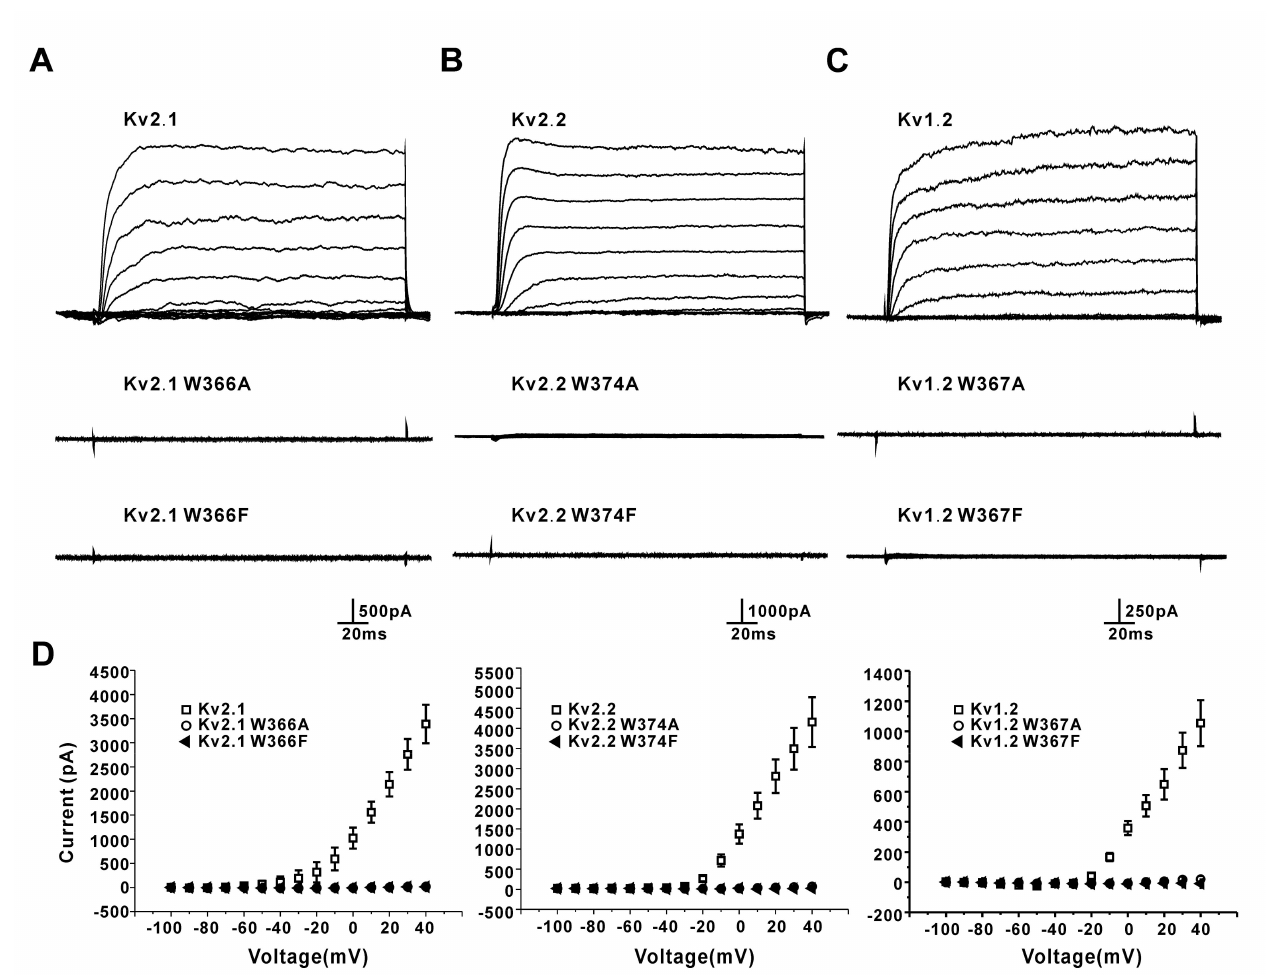
Figure 4. Effects of the mutations of the conserved tryptophan residue on the Kv2.1, Kv2.2, and Kv1.2 channel currents in HEK293 cells. ( A ) Representative currents for the Kv2.1 wild-type, W366A, and W366F mutant channels. ( B ) Representative currents for the Kv2.2 wild-type, W374A, and W374F mutant channels. ( C ) Representative currents for the Kv1.2 wild-type, W367A, and W367F mutant channels. ( D ) I-V plots of the outward currents of the Kv2.1, Kv2.2, and Kv1.2 wild-type and mutant channels ( n =